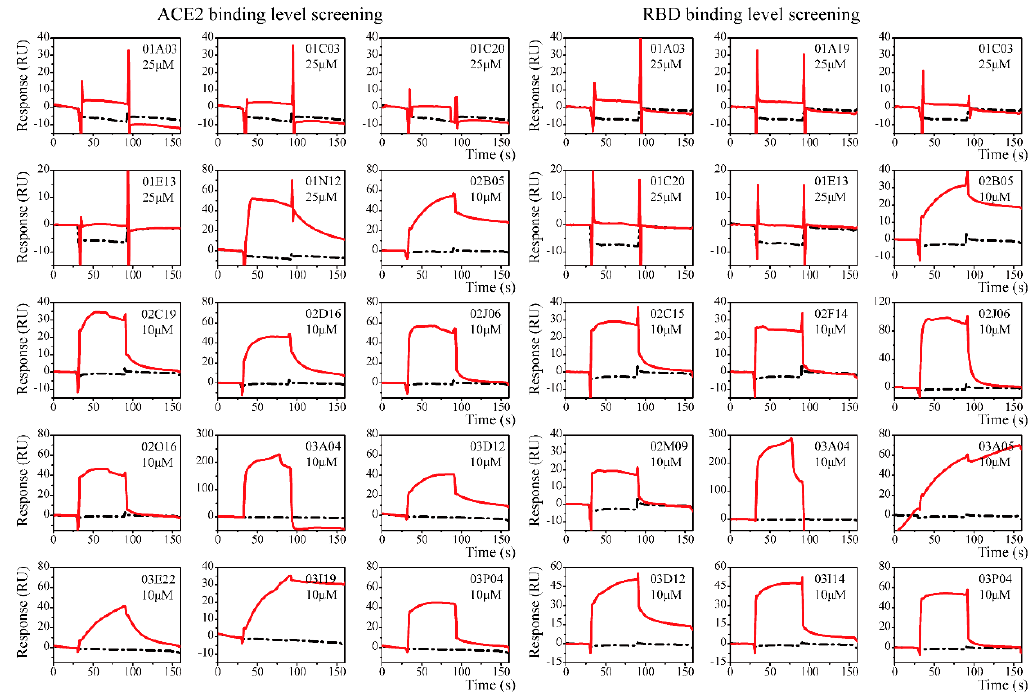
Figure 2. The sensorgrams of the Binding Level Screen hits. Binding curves of immobilized ACE2 (left) and S-RBD (right). Data are shown as red lines, and the blank control data are shown in black. Response with molecular weight adjustment was the selection theory. Top five compounds on each plate (three plates in total) were chosen as the hits.